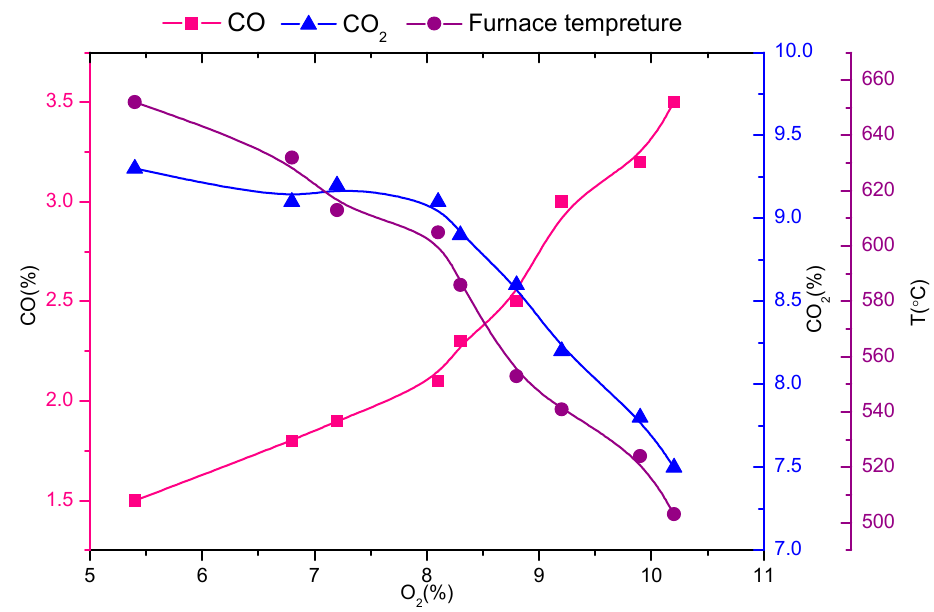
Figure 2. Relationship between furnace temperature, O 2 , CO, and CO 2.